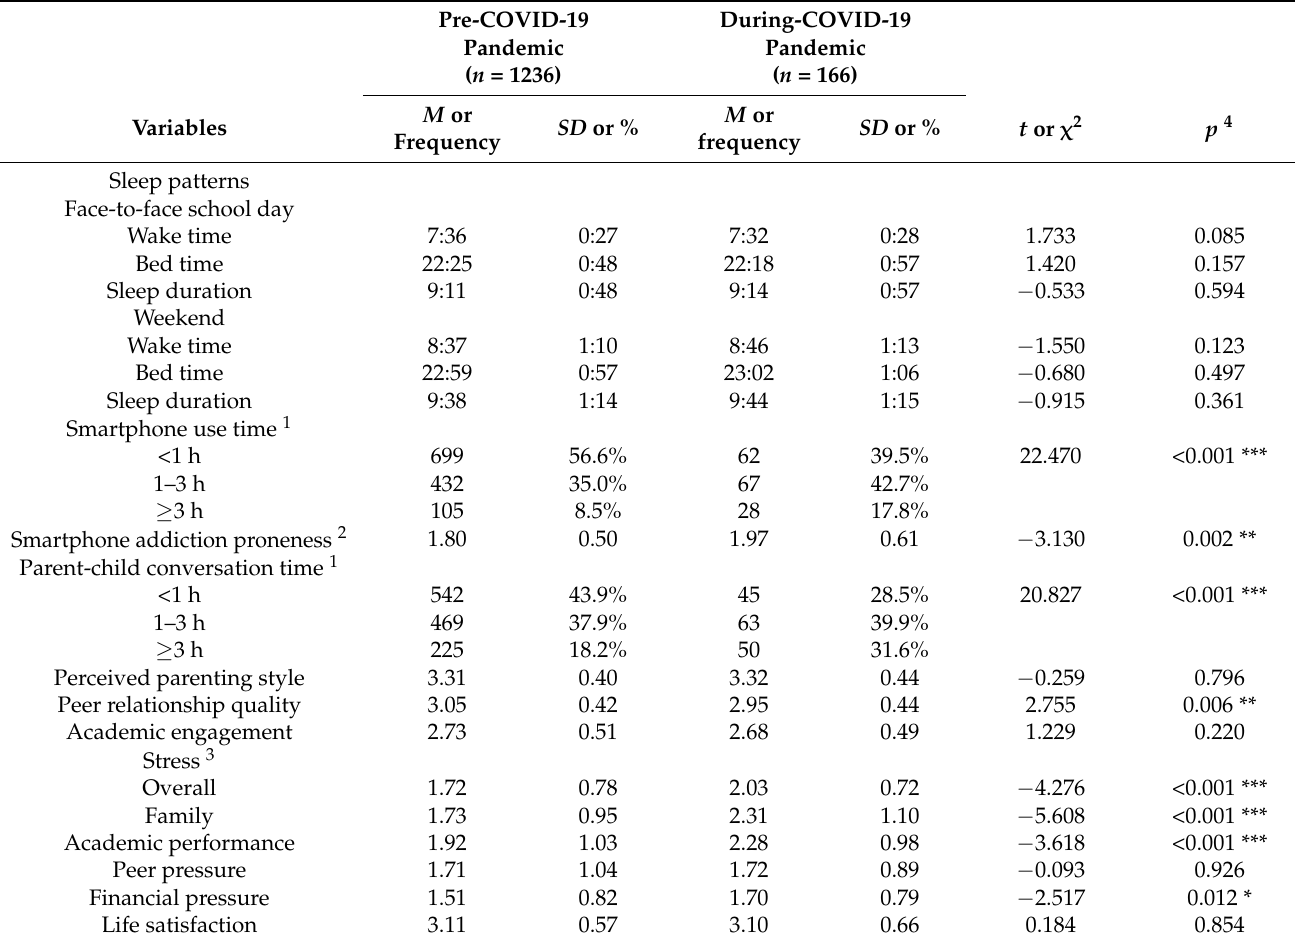
Table 1. Descriptive statistics and group differences for daily life and psychological well-being